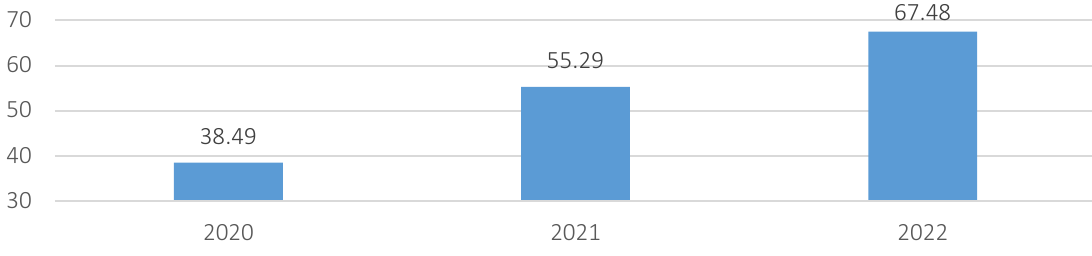
Figure A4. Volumes of completed and funded scientific research works and grants under the special fund, milion